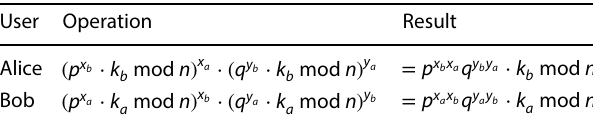
Table 8 The operations performed at each side after the public keys are exchanged User Operation